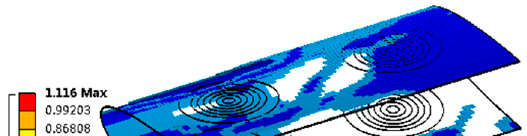
Figure 16. 1, 3 or 2, 4 of four coils are used (Mode 2).